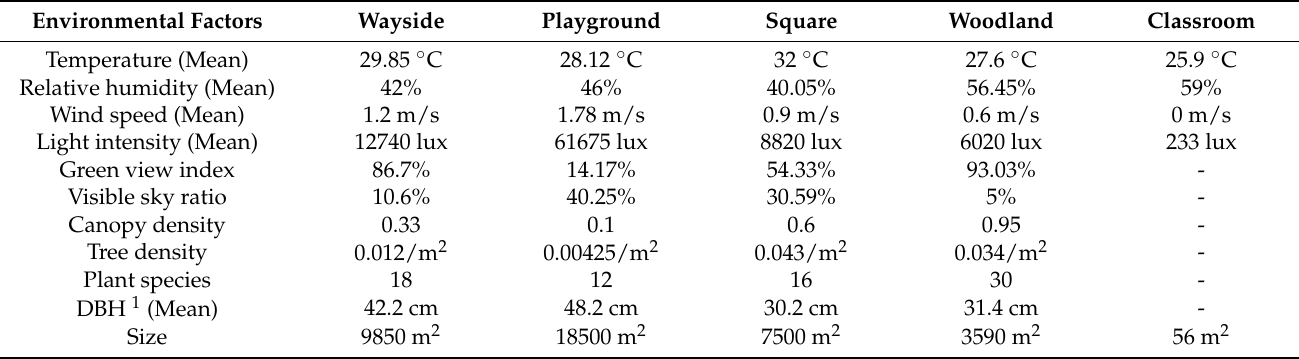
Table 1. The environmental elements of the four sample plots and the classroom control.